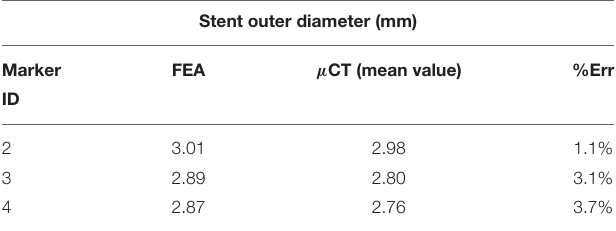
TABLE 3 | Comparison between the average measure of the stent outer diameter through µ CT and numerical simulations after deployment in the idealized vessel